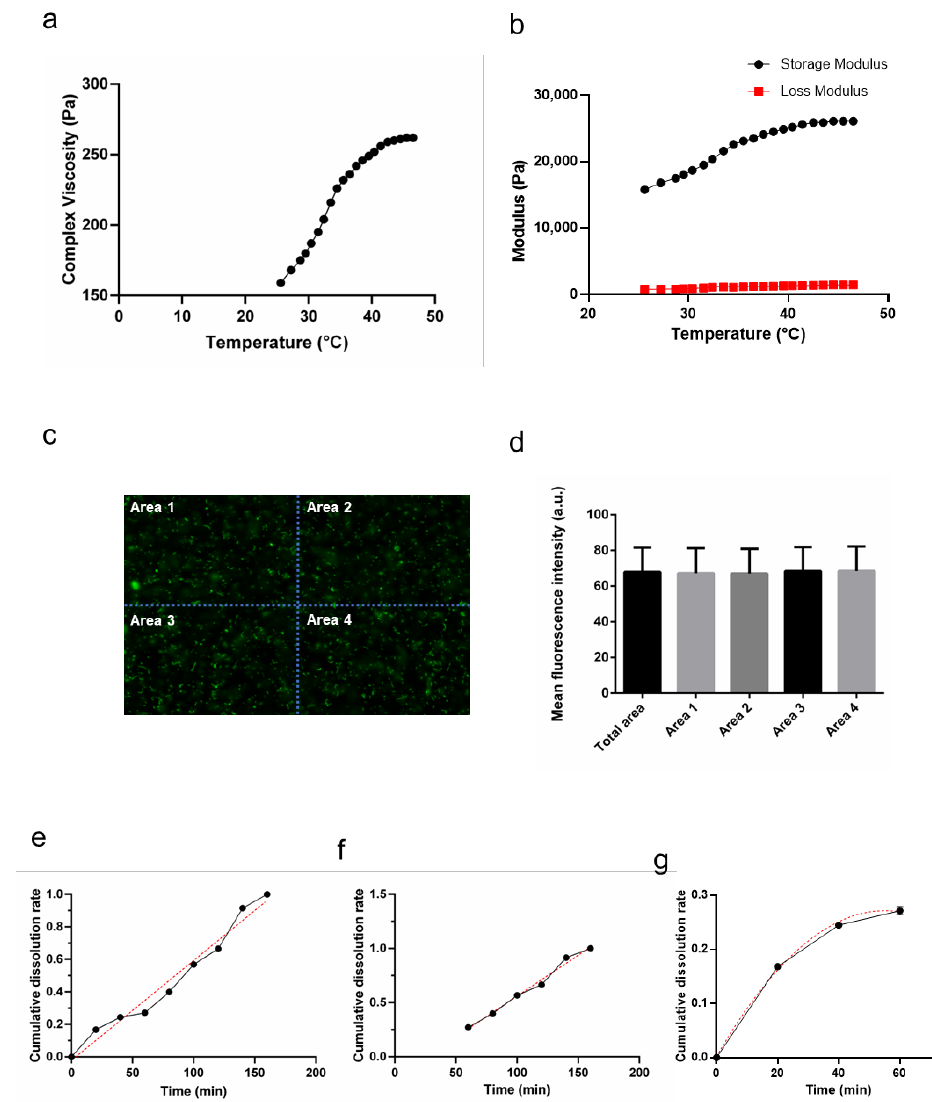
Figure 2. Physical – chemical properties of the gels. ( a ). The complex viscosity of the gels. ( b ). Flow curves at elevated temperatures from 25 °C and 46 °C. ( c ). The representative image of the distribution of L. gasseri within the gel and a schematic representation of the zoning. ( d ). The mean fluorescence intensity analysis of the regions in Figure 2C (Mean ± SD, n = 3). ( e ). The release curve and the simulated fitted line with a nonlinear fit to the entire curve. ( f ). The plot of nonlinear fit to the points of the release curve after 60 min and the fitted line. ( g ). The plot of a nonlinear fit to the points of the release curve before 60 min and the fitted line.